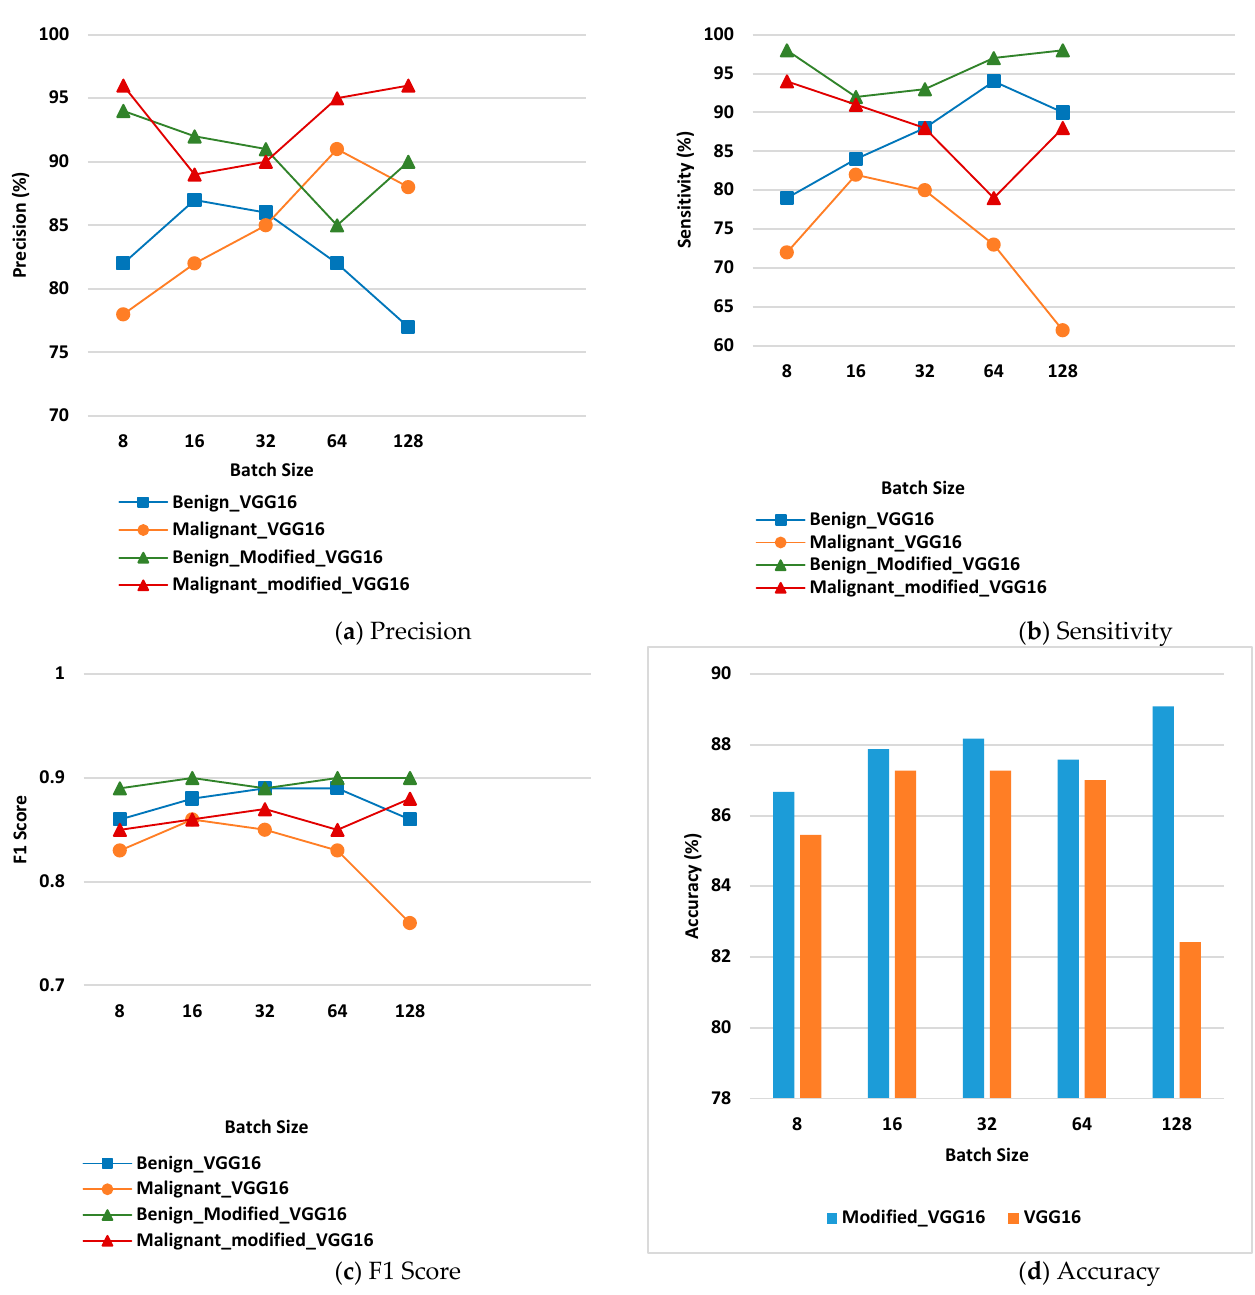
Figure 9. Confusion Matrix Parameters ( a ) Precision, ( b ) Sensitivity, ( c ) F1 Score, ( d )